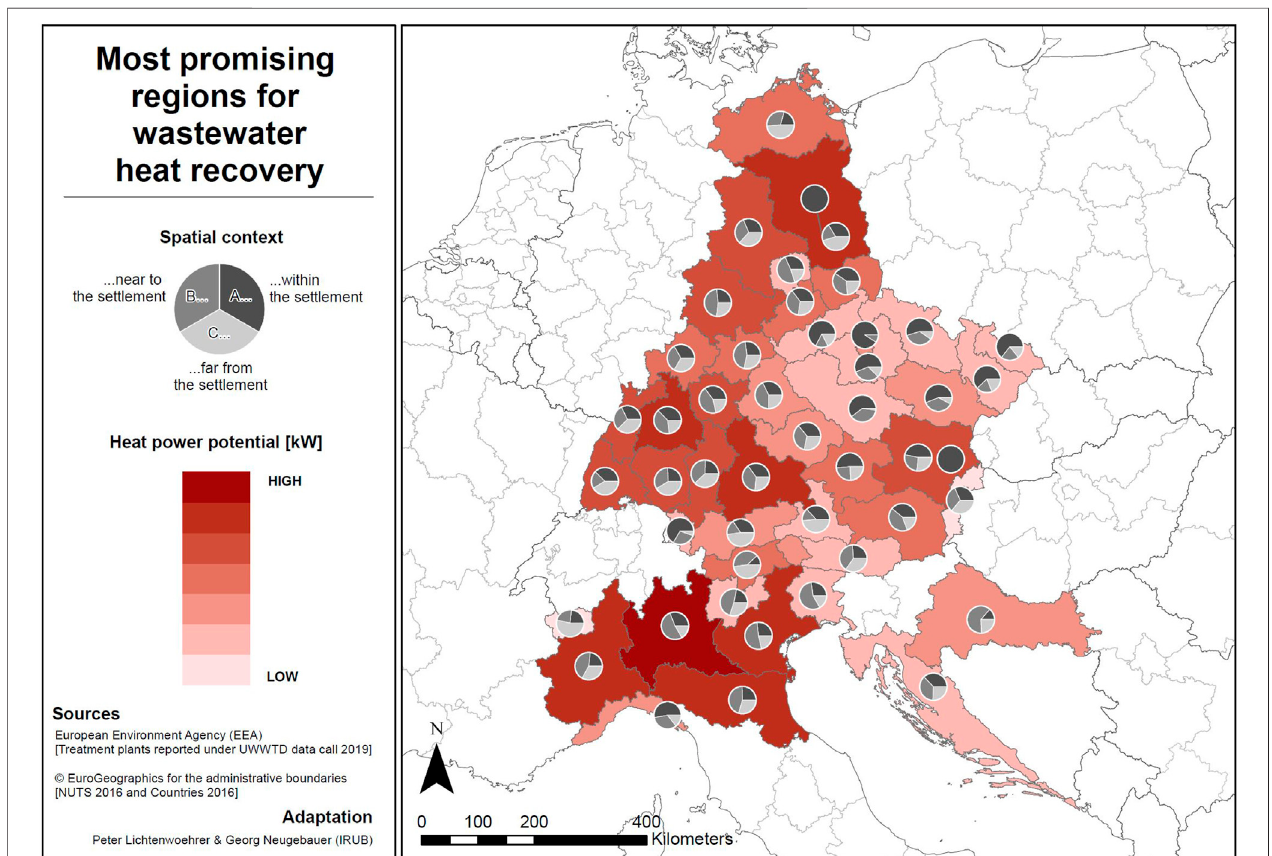
FIGURE 3 | NUTS2 regions with the highest heat power potential and its spatial context (own illustration).